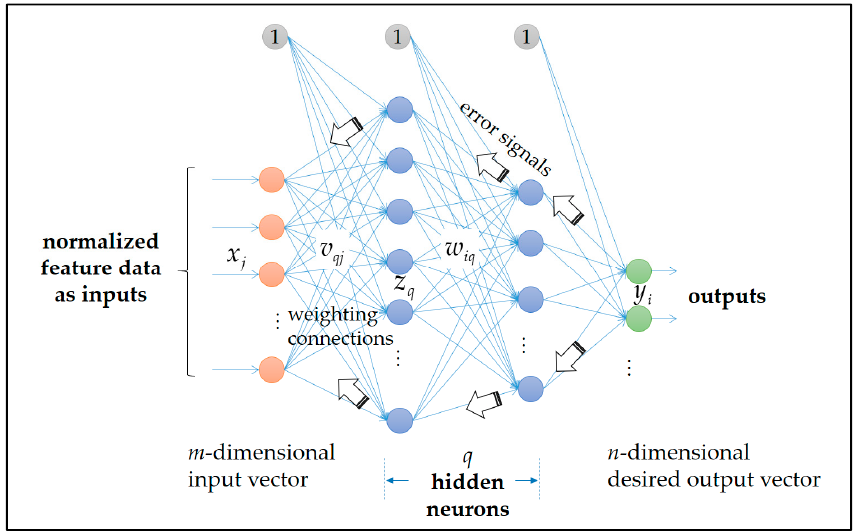
Figure 5. Structure of the feed-forward ANN conducting the Gradient Descent (GD) process as well as the PSO as the training algorithm.